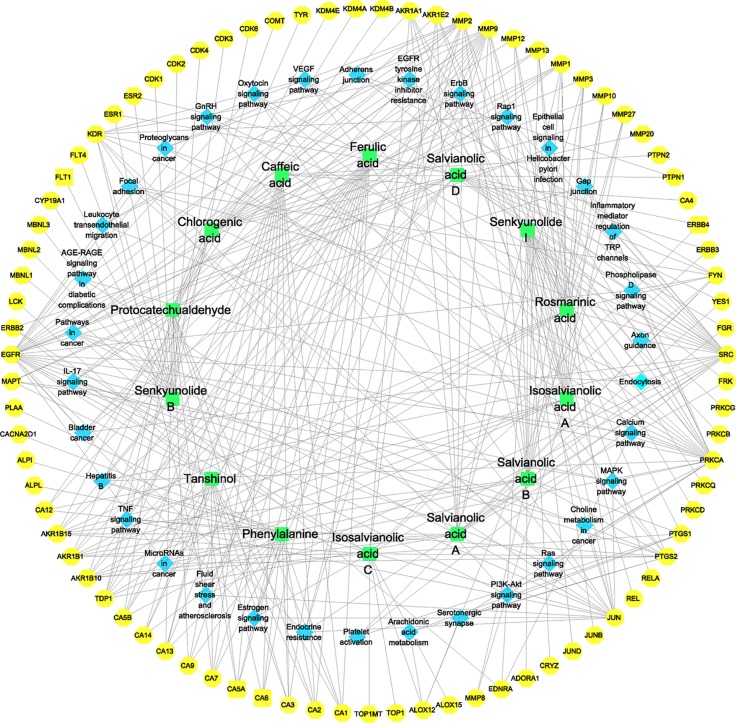
Component–target–pathway network for the identified components of GXNT on thrombus. The green nodes represent the identified components, the blue nodes represent pathways, and the yellow nodes represent targets. Edges represent the interactions between the compounds and the targets in the network.